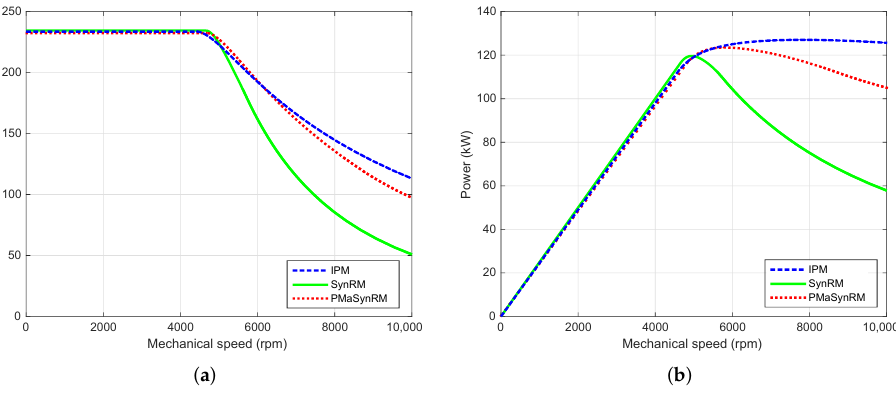
Figure 14. Comparison of torque and power variations versus speed of the three motors (the benchmark IPM motor: dashed lines; the SynRM: solid lines; the PMaSynRM: dotted lines): ( a ) Torque versus speed; ( b ) Power versus